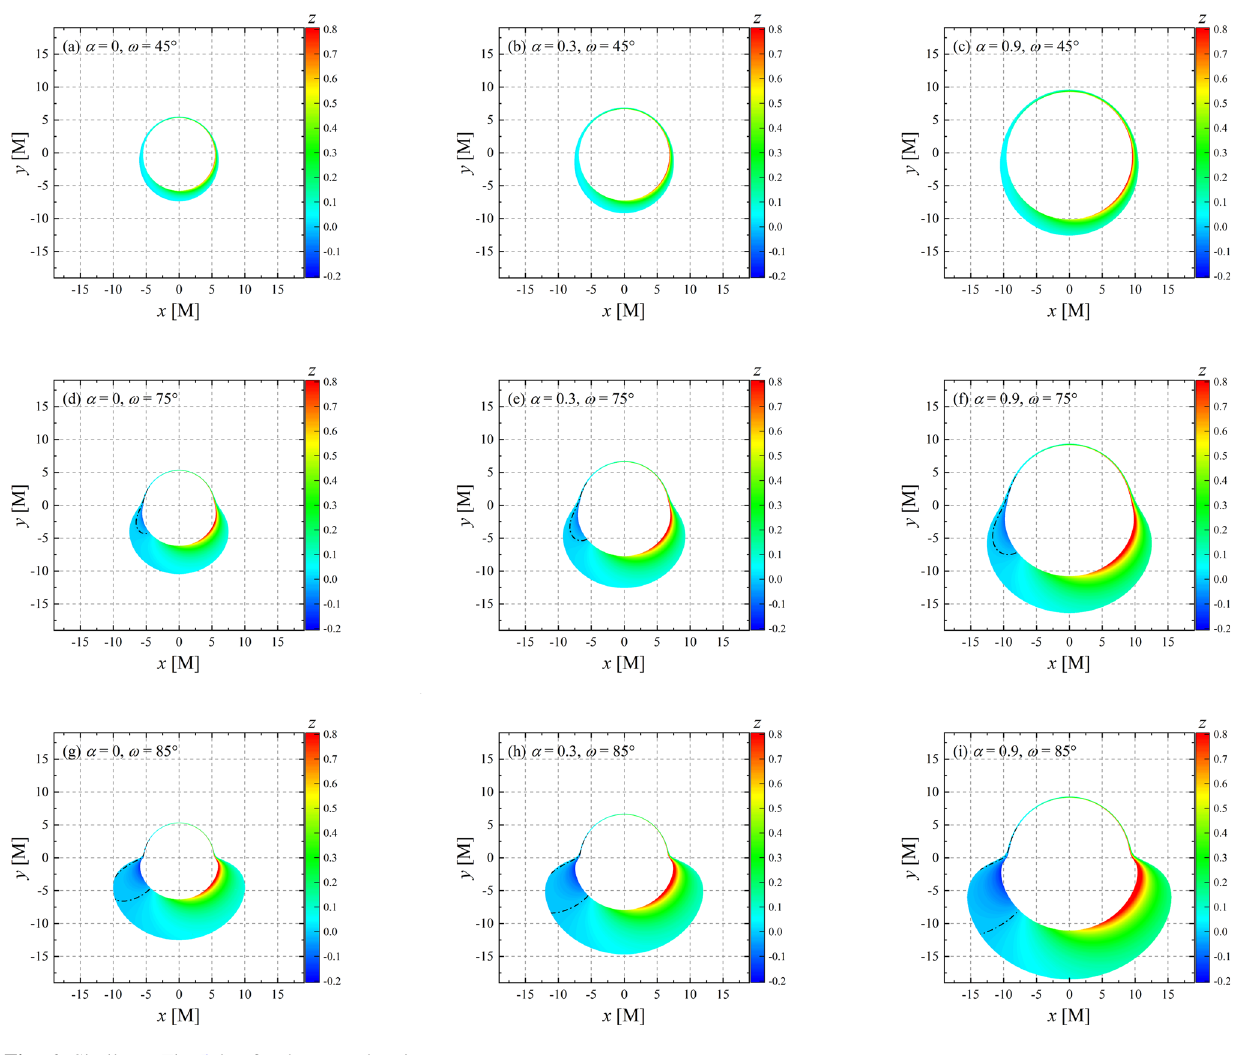
Fig. 6 Similar to Fig.5, but for the secondary images